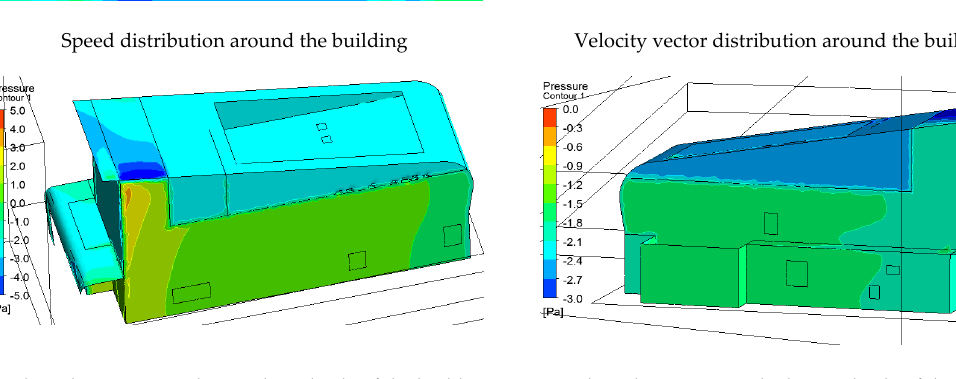
Figure 7. Analysis of the outdoor wind speed and wind pressure outside the building.